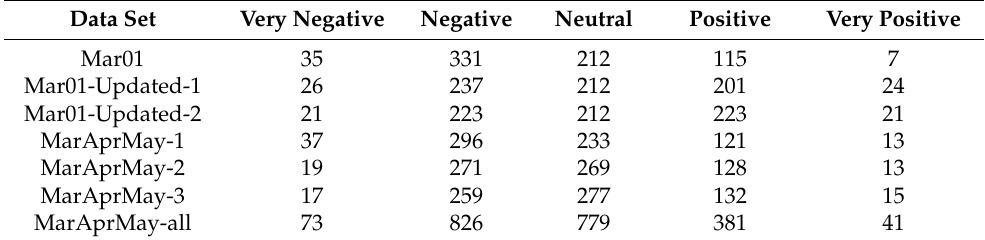
Table 3. The numbers of tweets in the five sentiment categories in each data